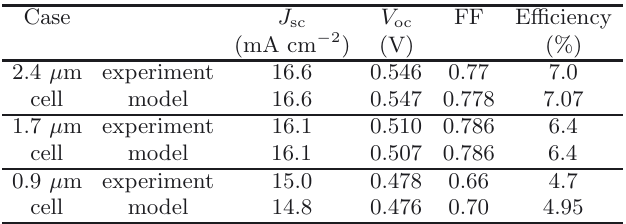
Fig. 3. The experimental (expt) external quantum efficiency (EQE) curves of the 2.4 μ m and 1.7 μ m epi-Si NIP cells and the reflection from the 2.4 μ m device (symbols) under AM1.5 light, 0 V, compared to model results (lines). Table 1. Comparison of the measured and simulated solar cell output parameters for the deposited epi-Si solar